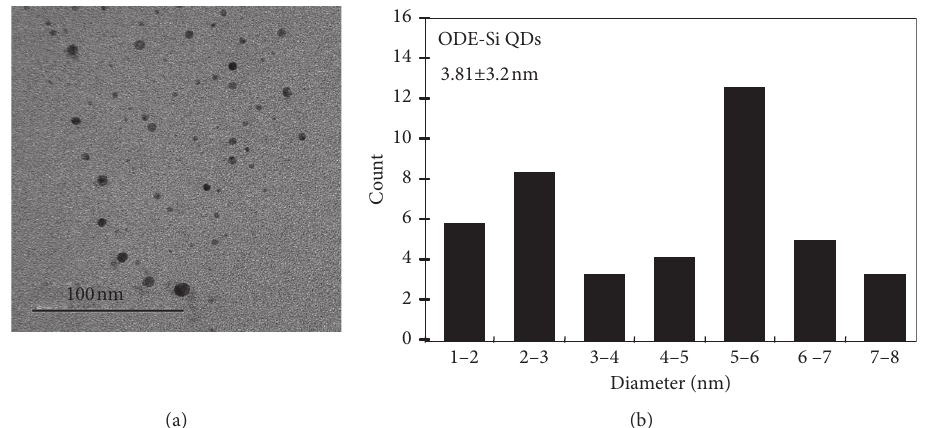
Figure 4: Transmission electron microscopy (FE-TEM) of ODE-Si QDs before size separation by column